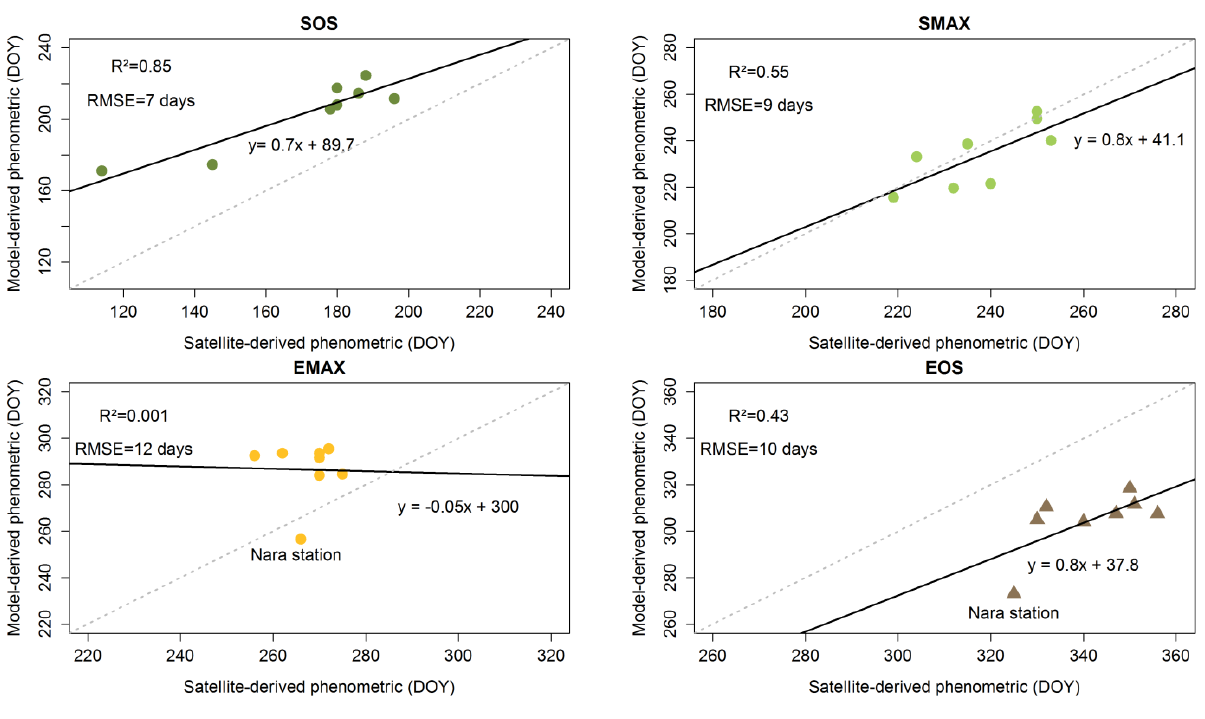
Figure 6. Linear regression for the median satellite- and model-derived phenometrics values for the eight stations during 2007. The diagonal dotted lines represent the 1:1